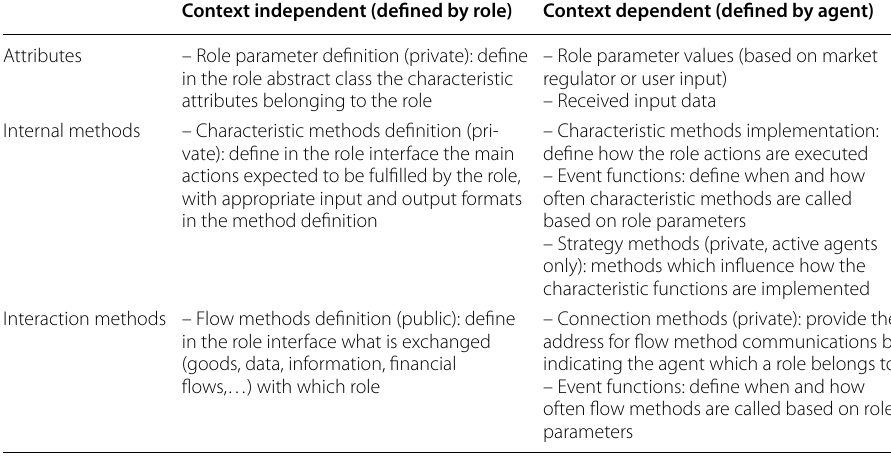
Table 3 Summary of agent